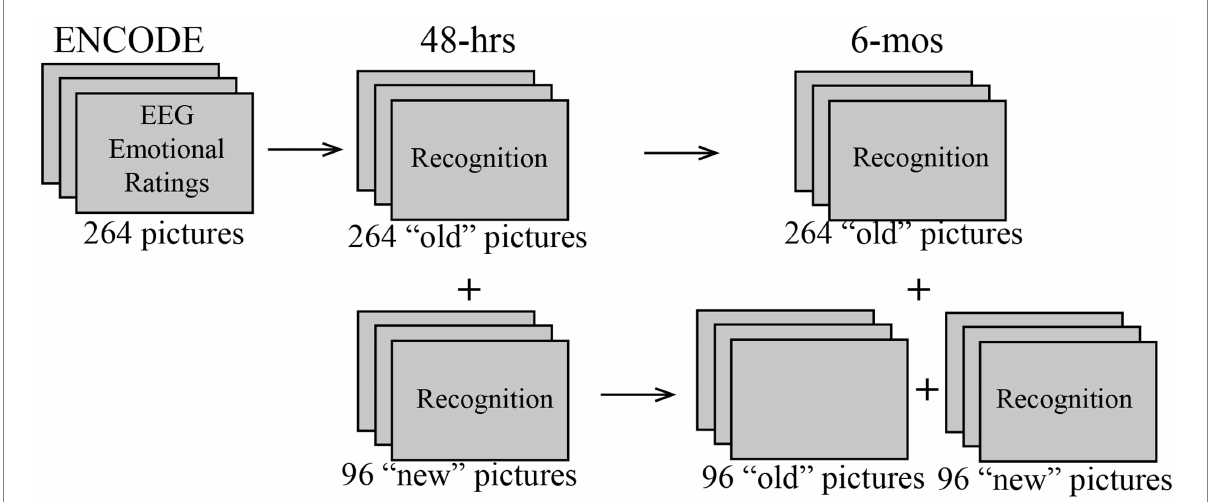
FIGURE 1 Schematic diagram of the study design showing picture sets that were used in the ENCODE, and 48-h and 6-mos recognition sessions. To examine subsequent memory effects (SME), EEG data from the ENCODE session were analyzed as a function of recognition outcomes observed in the 48-h and 6-mos sessions. In the 6-mos session, the unmarked pictures were used as lures but were not analyzed for recognition